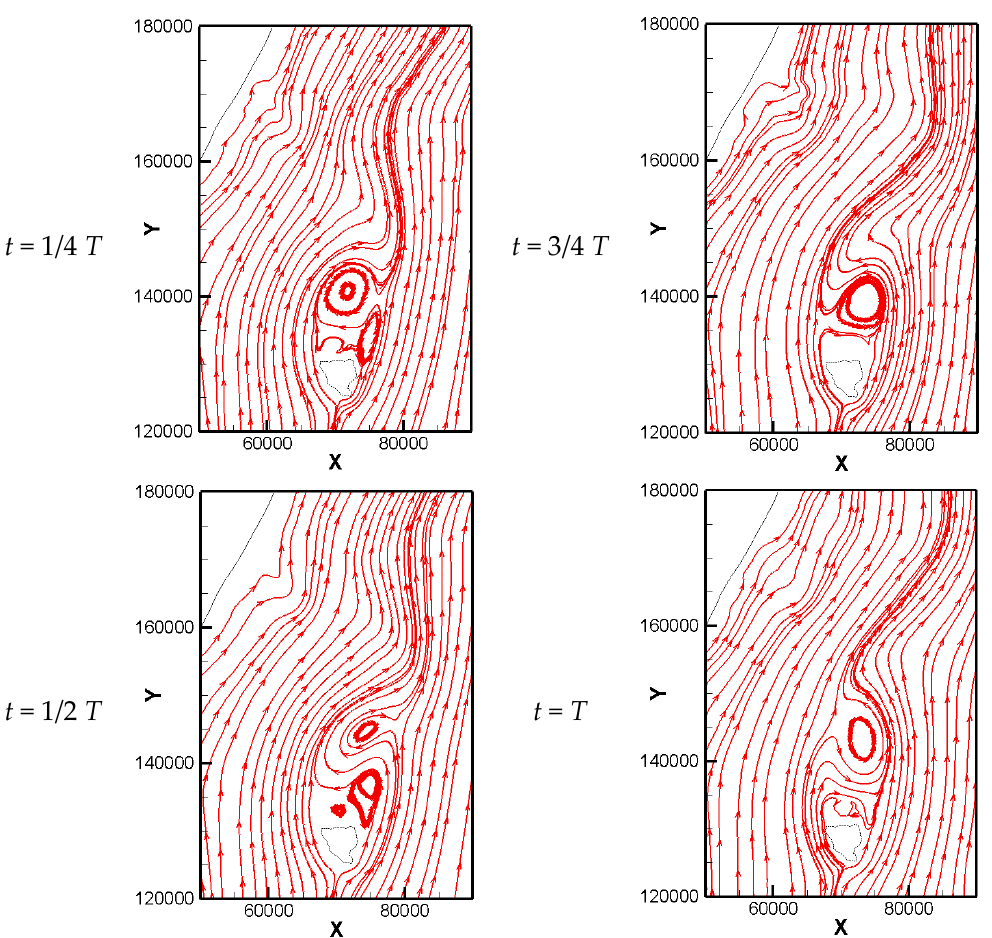
Figure 8. Flow streamlines of the Green Island wakes in the no wind forcing case.